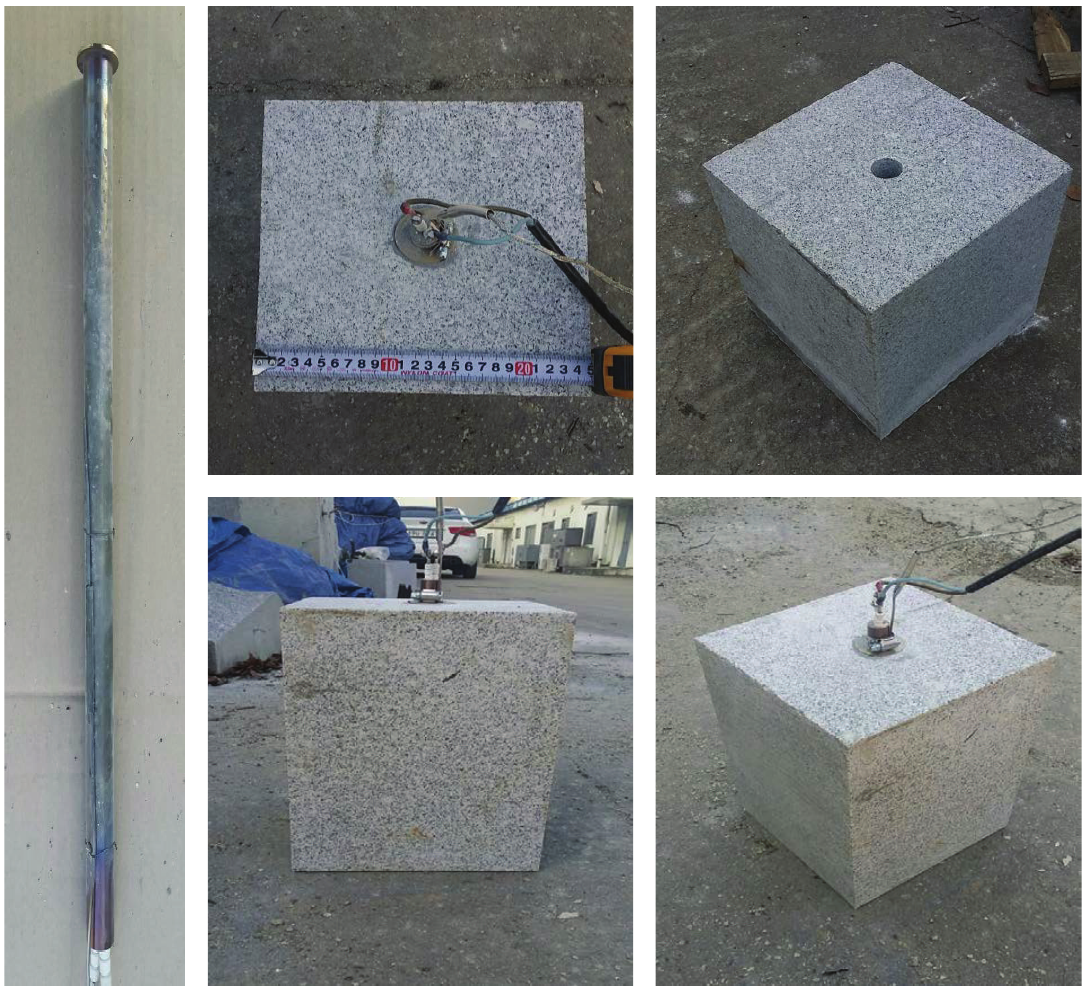
Figure 5: Setup for experimental field tests (heater and granite rock at the Case 1 model).